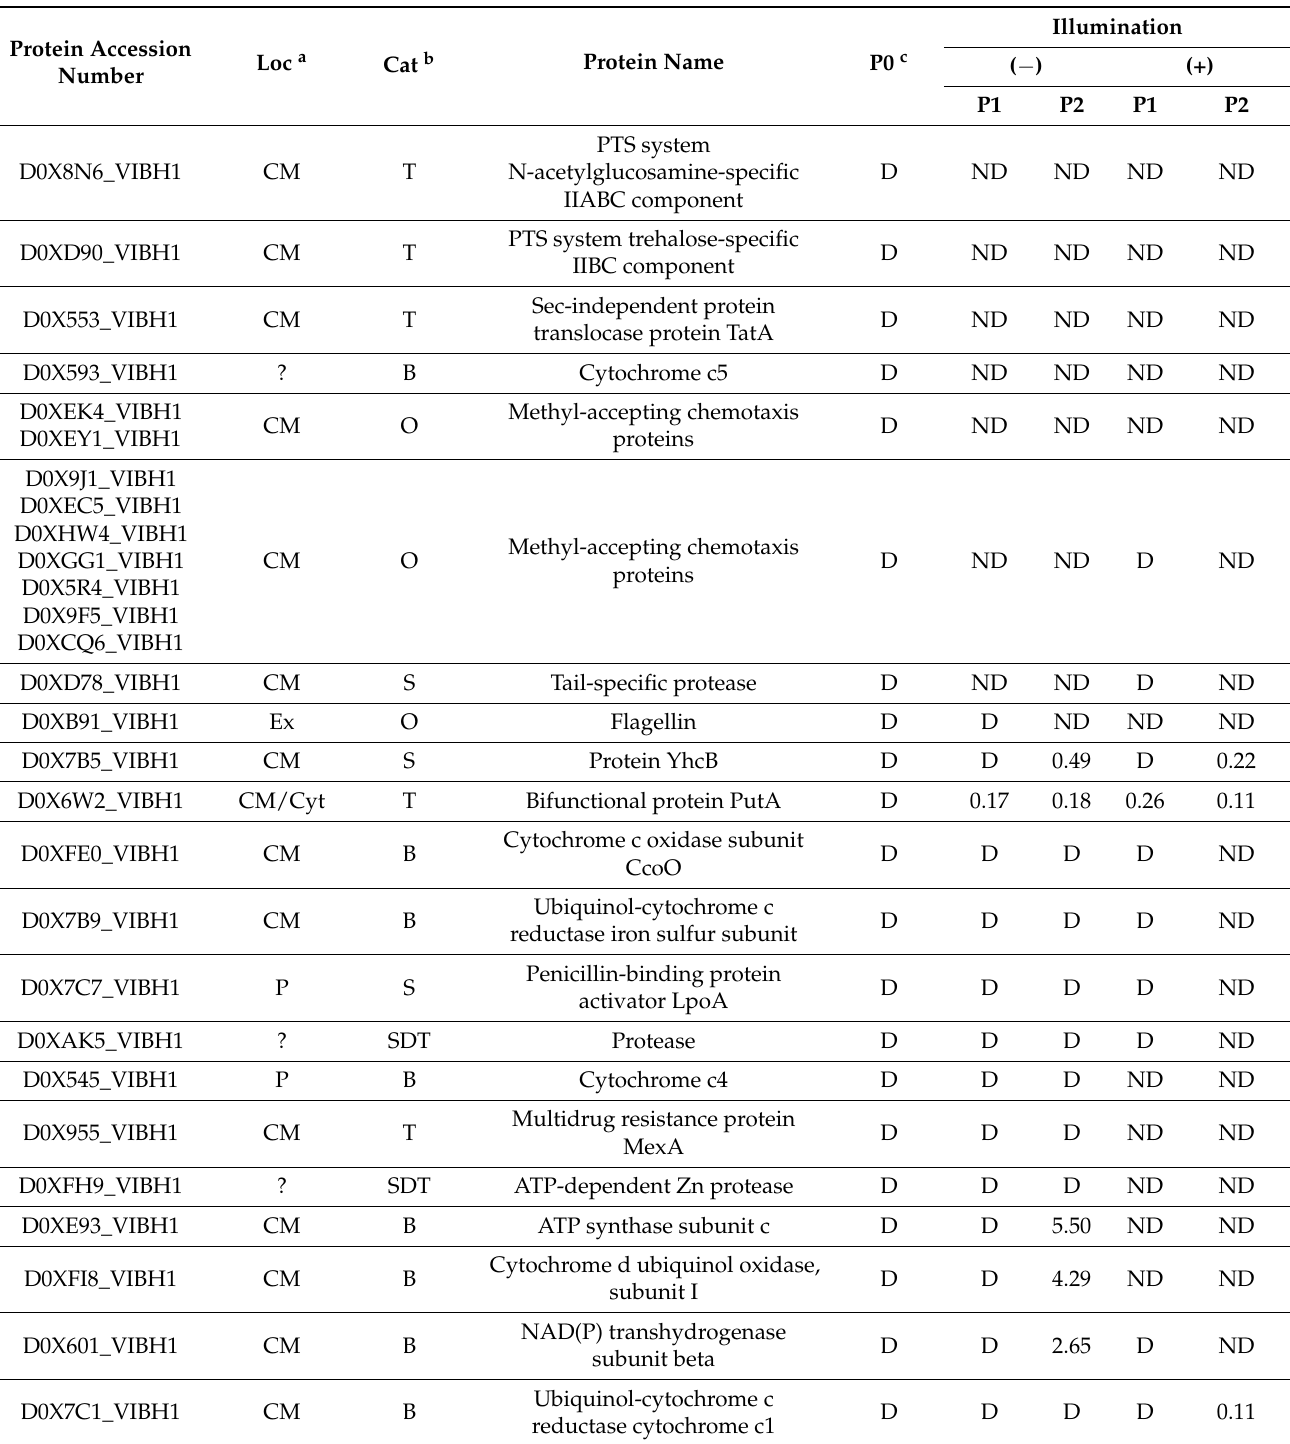
These proteins were detected earlier (6 d) in populations maintained under illumination. Table 2. Changes in the level of membrane proteins of V. harveyi ATCC 14126 T subjected to starvation in seawater at 20 ◦ C. The data are presented for the initial population (time P0) and populations analyzed after starvation of V. harveyi for 6 (P1) and 21 (P2) days in the absence ( − ) and presence (+) of